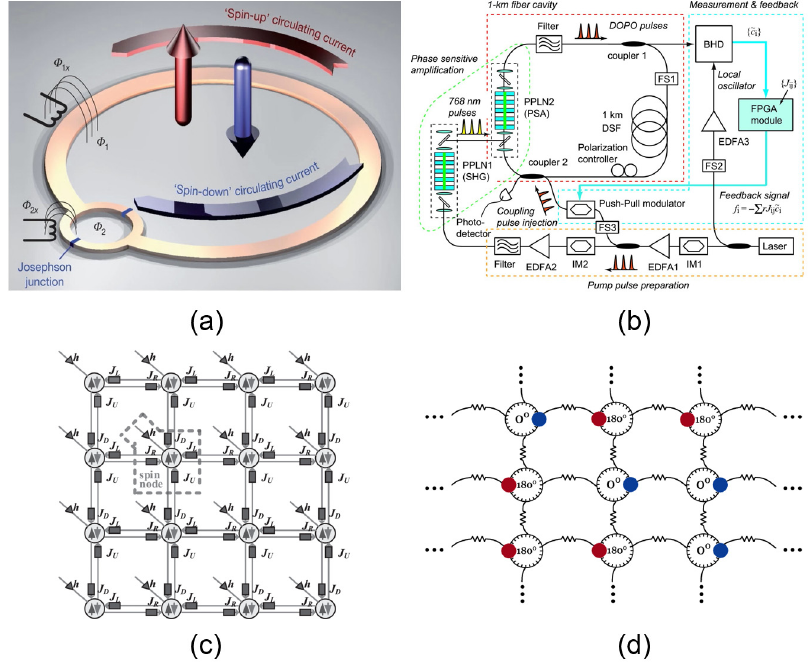
Figure 2. Schematic diagram of four different types of Ising machines: ( a ) quantum annealing Ising machine [5]; ( b ) optical coherent Ising machine [9]; ( c ) CMOS digital Ising machine [15]; ( d ) oscillator network Ising machine [18].